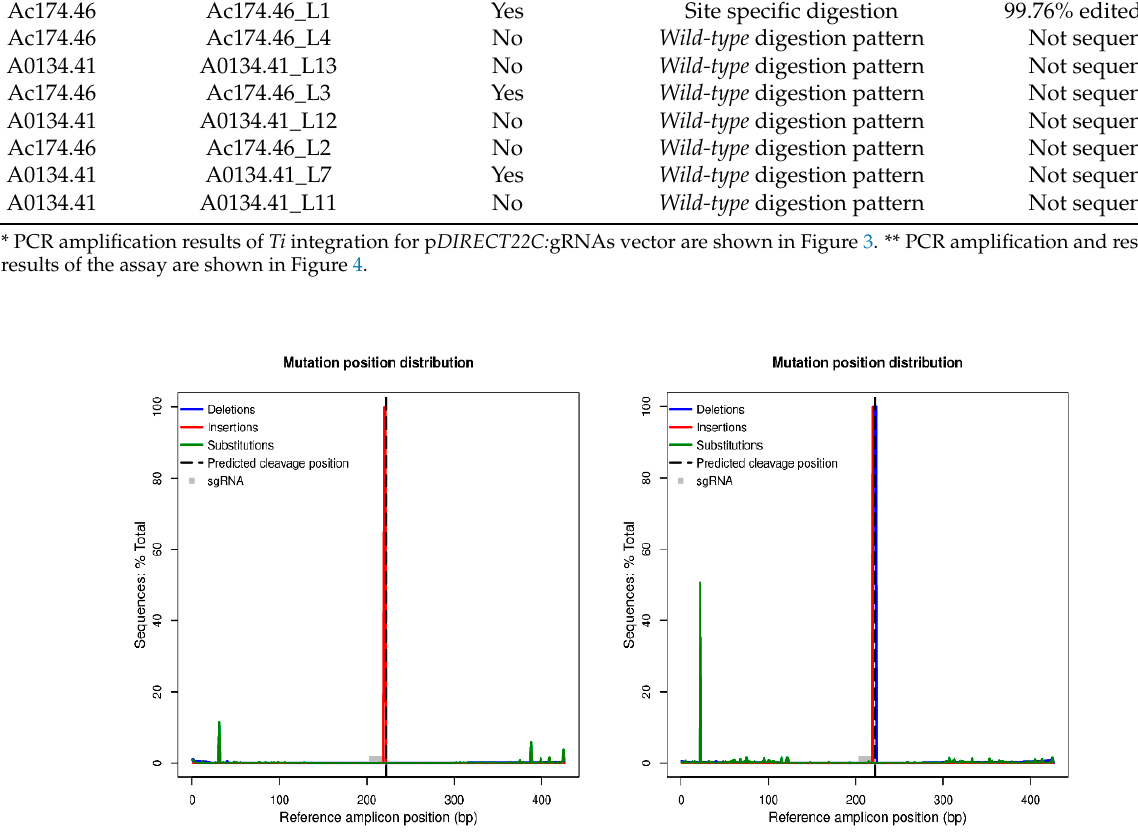
Figure 5. CRISPResso output analysis for the two regenerated lines named A0134.41_L3 (on the left) and Ac174.46_L1 (on the right). The two plots allow the quantification and visualization of the position and type of outcomes within the amplicon sequence reporting the frequency of mutations detected across sgRNA1 locus in this case. The reference amplicon position in the base pair is reported on the X-axis, while the Y-axis reports the percentage of reads showing mutations, with the effective number of mutations in brackets. Mutation types are color-coded: insertions are in red, deletions are